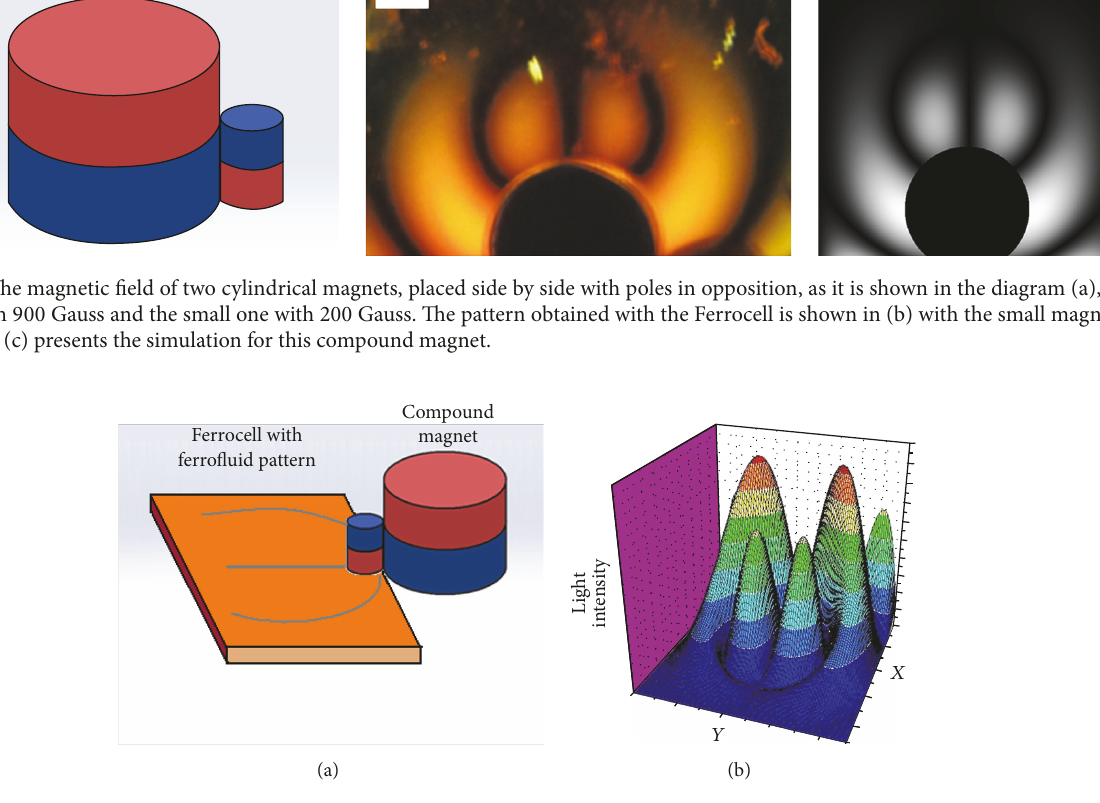
Figure 7: The diagram of the magnets of the previous case in (a) and the plot of the light intensity of two cylindrical magnets with different sizes and magnetic field intensities in (b), showing the result of the magnetic field of the small magnet being embraced by the magnetic field of the large magnet, resembling the interaction in the solar wind being deflected by the magnetic field of the